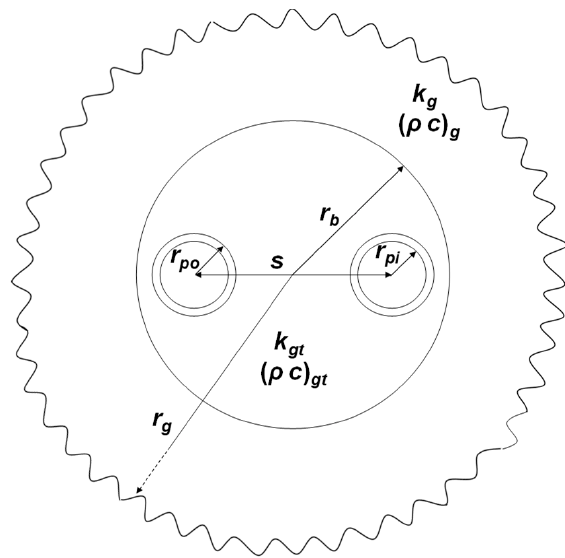
Figure 1. Sketch of the selected BHE cross section, with surrounding ground.